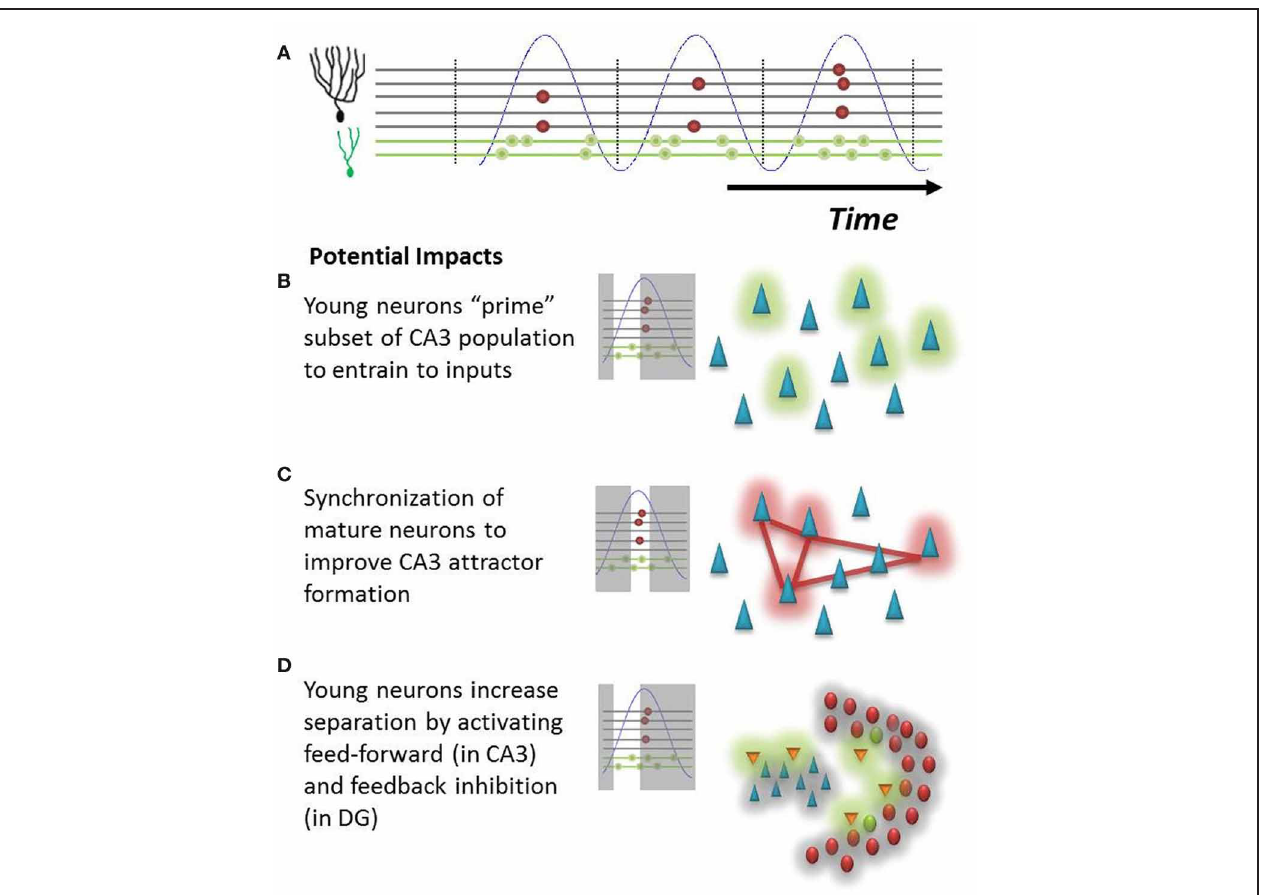
FIGURE 3 | Potential impact of hypothesis on DG-CA3 relationship. (A) Illustration of population behavior predicted by hypothesis. Young neurons (green dots) will fire at many phases of theta (blue), whereas mature neurons (red dots) will fire at only the peak of EC population activity. (B) Early in the theta oscillation, young neurons will fire onto CA3 neurons, possibly priming a subset of pyramidal cells (green cloud) for the subsequent formation of